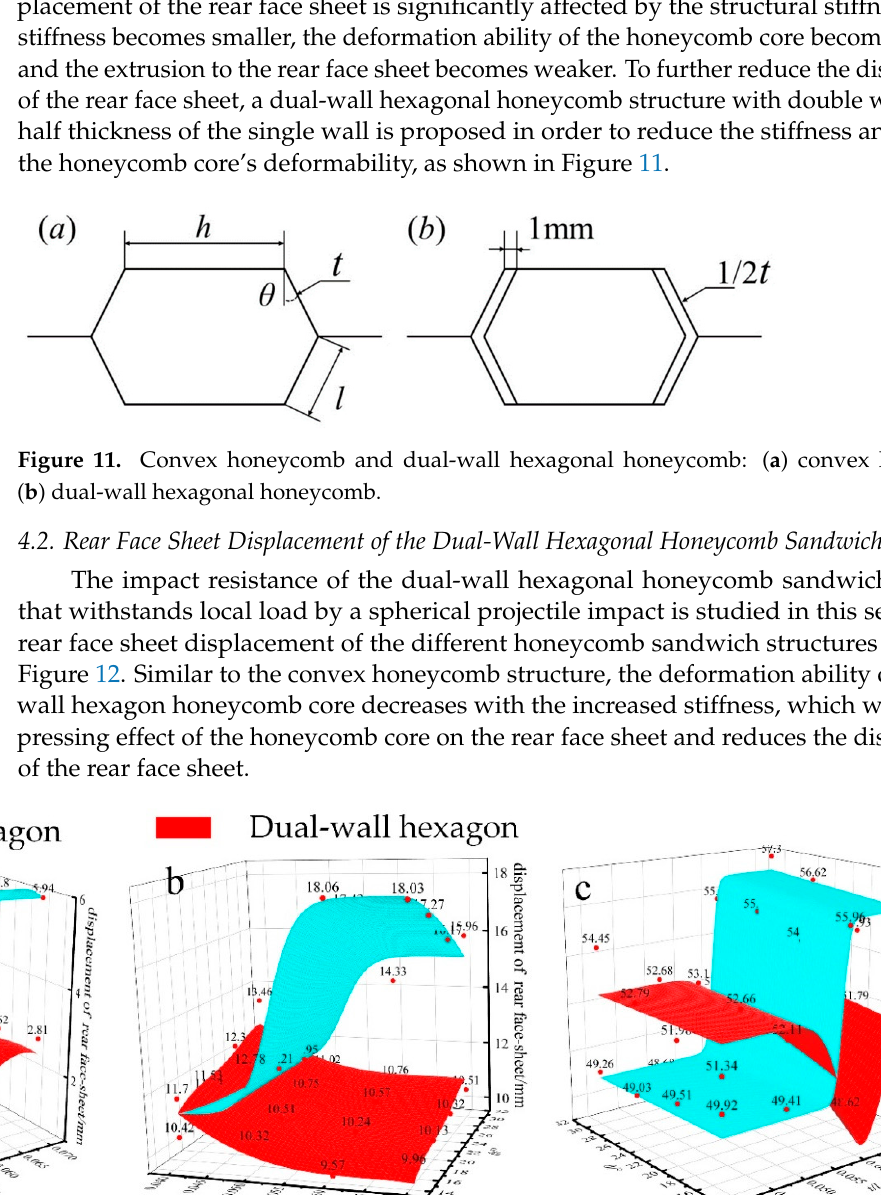
11 of 15 Figure 10. Deformation of the honeycomb structure with different geometric parameters under 100